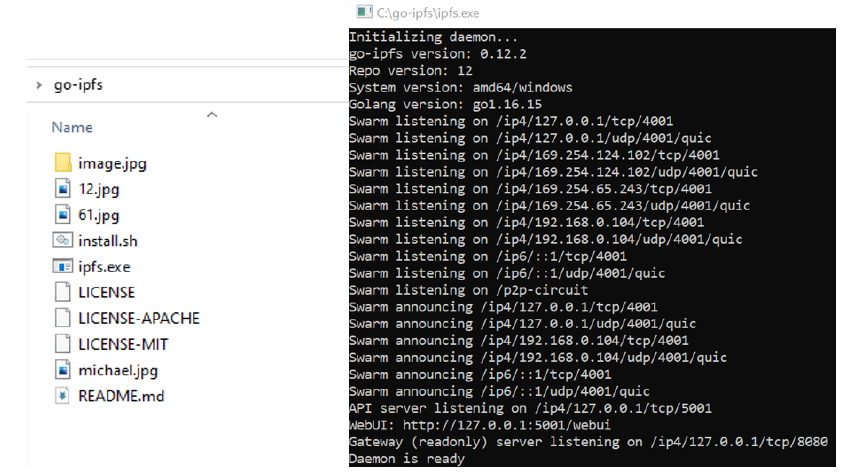
Figure 14. IPFS Execution and Daemon